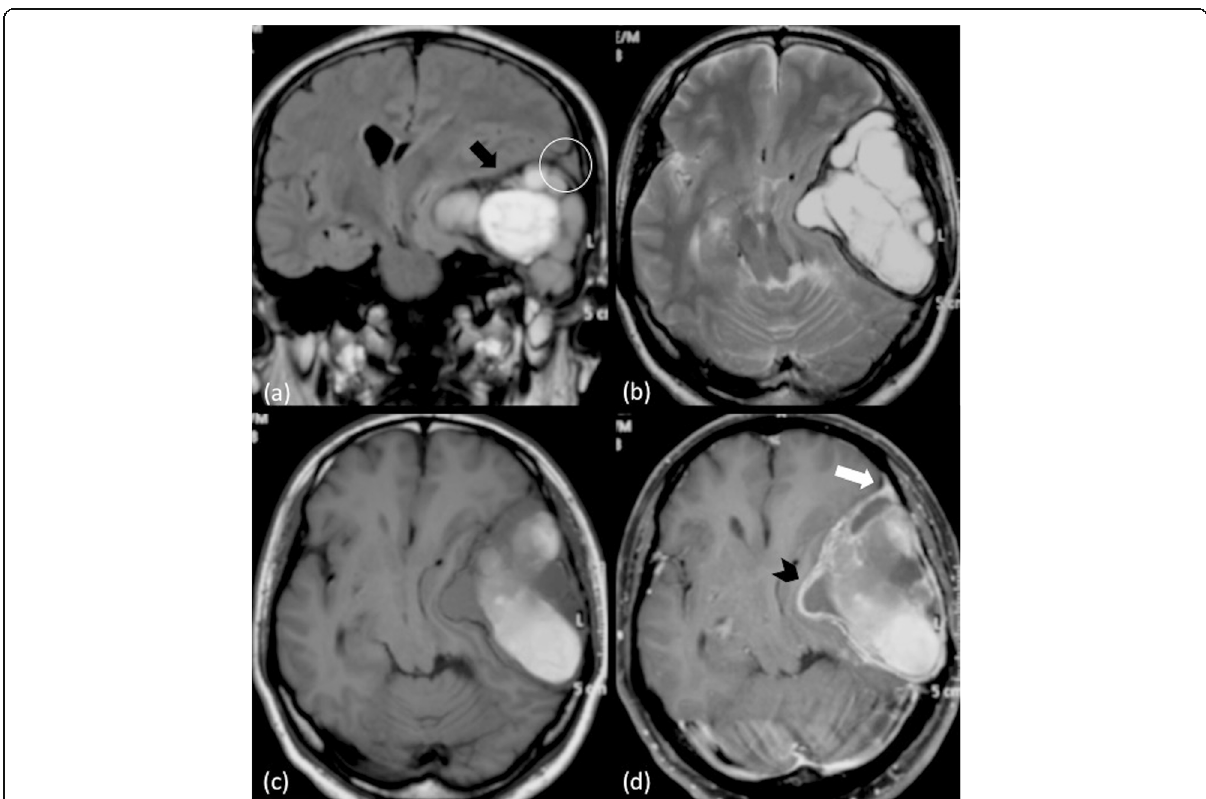
Fig. 2 Contrasted MRI of the brain. a Coronal FLAIR. b Axial T2-weighted. c Axial T1-weighted. d Axial post-contrast T1-weighted images. Coronal FLAIR showed that the tumour occupied the left temporal fossa (black arrow). The tumour was hyperintense on T2-weighted images ( b ), heterogeneously hyperintense on T1-weighted images ( c ), and had thick-wall peripheral enhancement (black arrowhead) in the post contrast T1- weighted sequence ( d ). The presence of a CSF cleft (circled) and dural tail (white arrowhead) suggested that the tumour is extra-axial